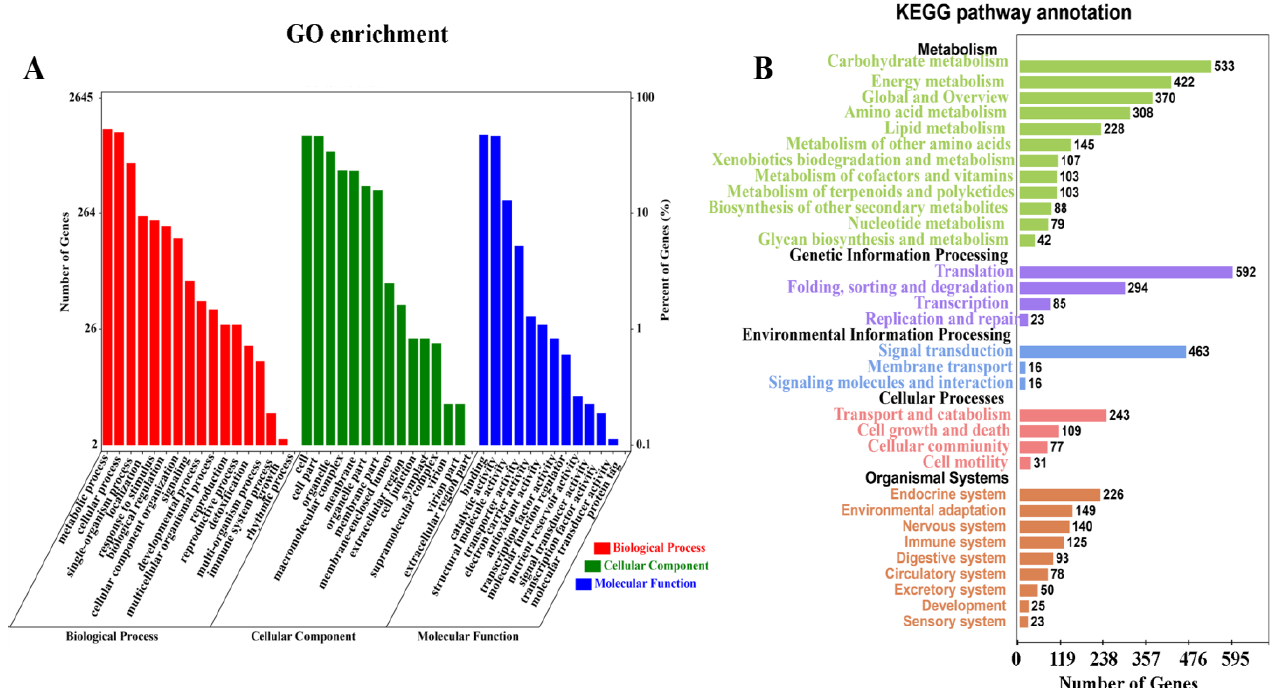
Figure 2. Functional annotations of DEGs based on GO and KEGG enrichment analysis. ( A ) Different colors show categories in the biological process (red), cellular component (green), and molecular functions (blue) relevant to plant physiology. The left y-axis represents the numbers of unigenes with BLASTx matches to each GO term. The right y-axis indicates the percentage of genes. ( B ) Major